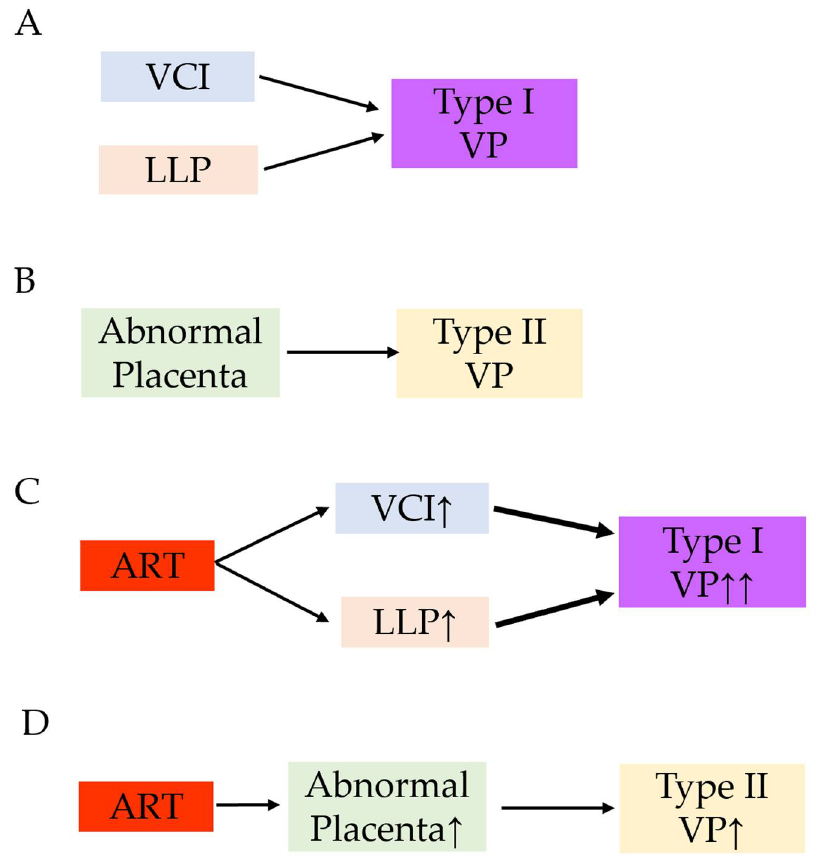
Figure 3. A hypothesis of the increased rate of type I and type II vasa previa in ART pregnancy.